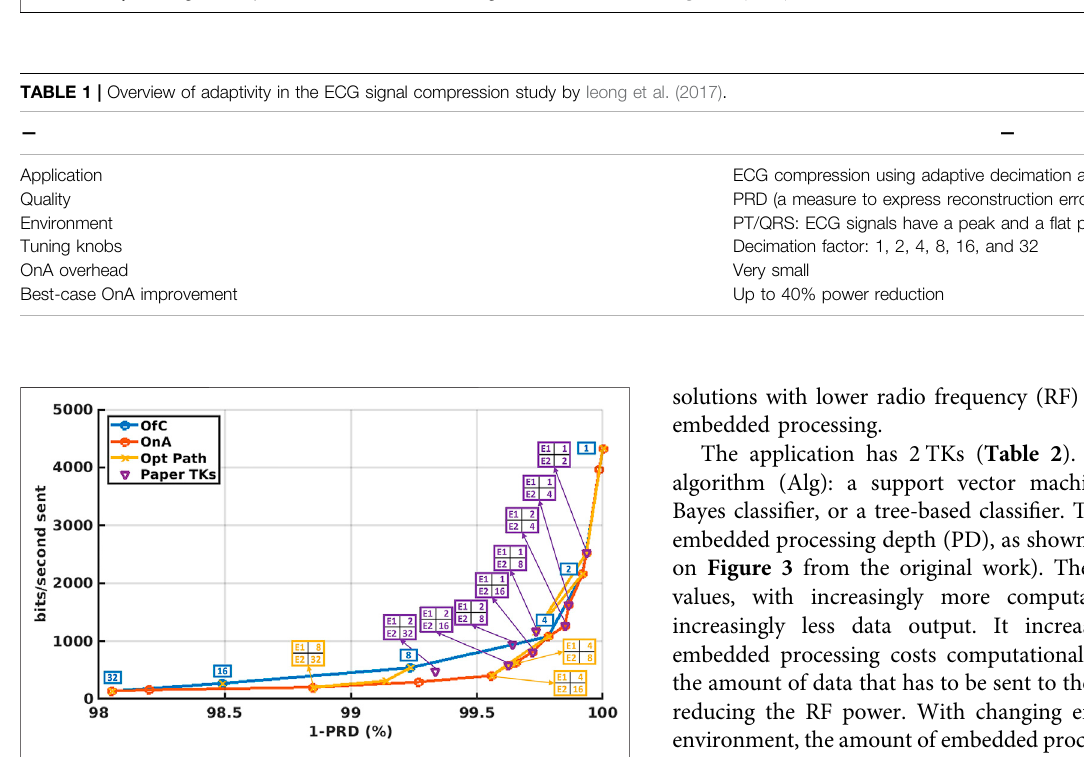
FIGURE 9 | Adaptive temporal decimation power bene fi ts from